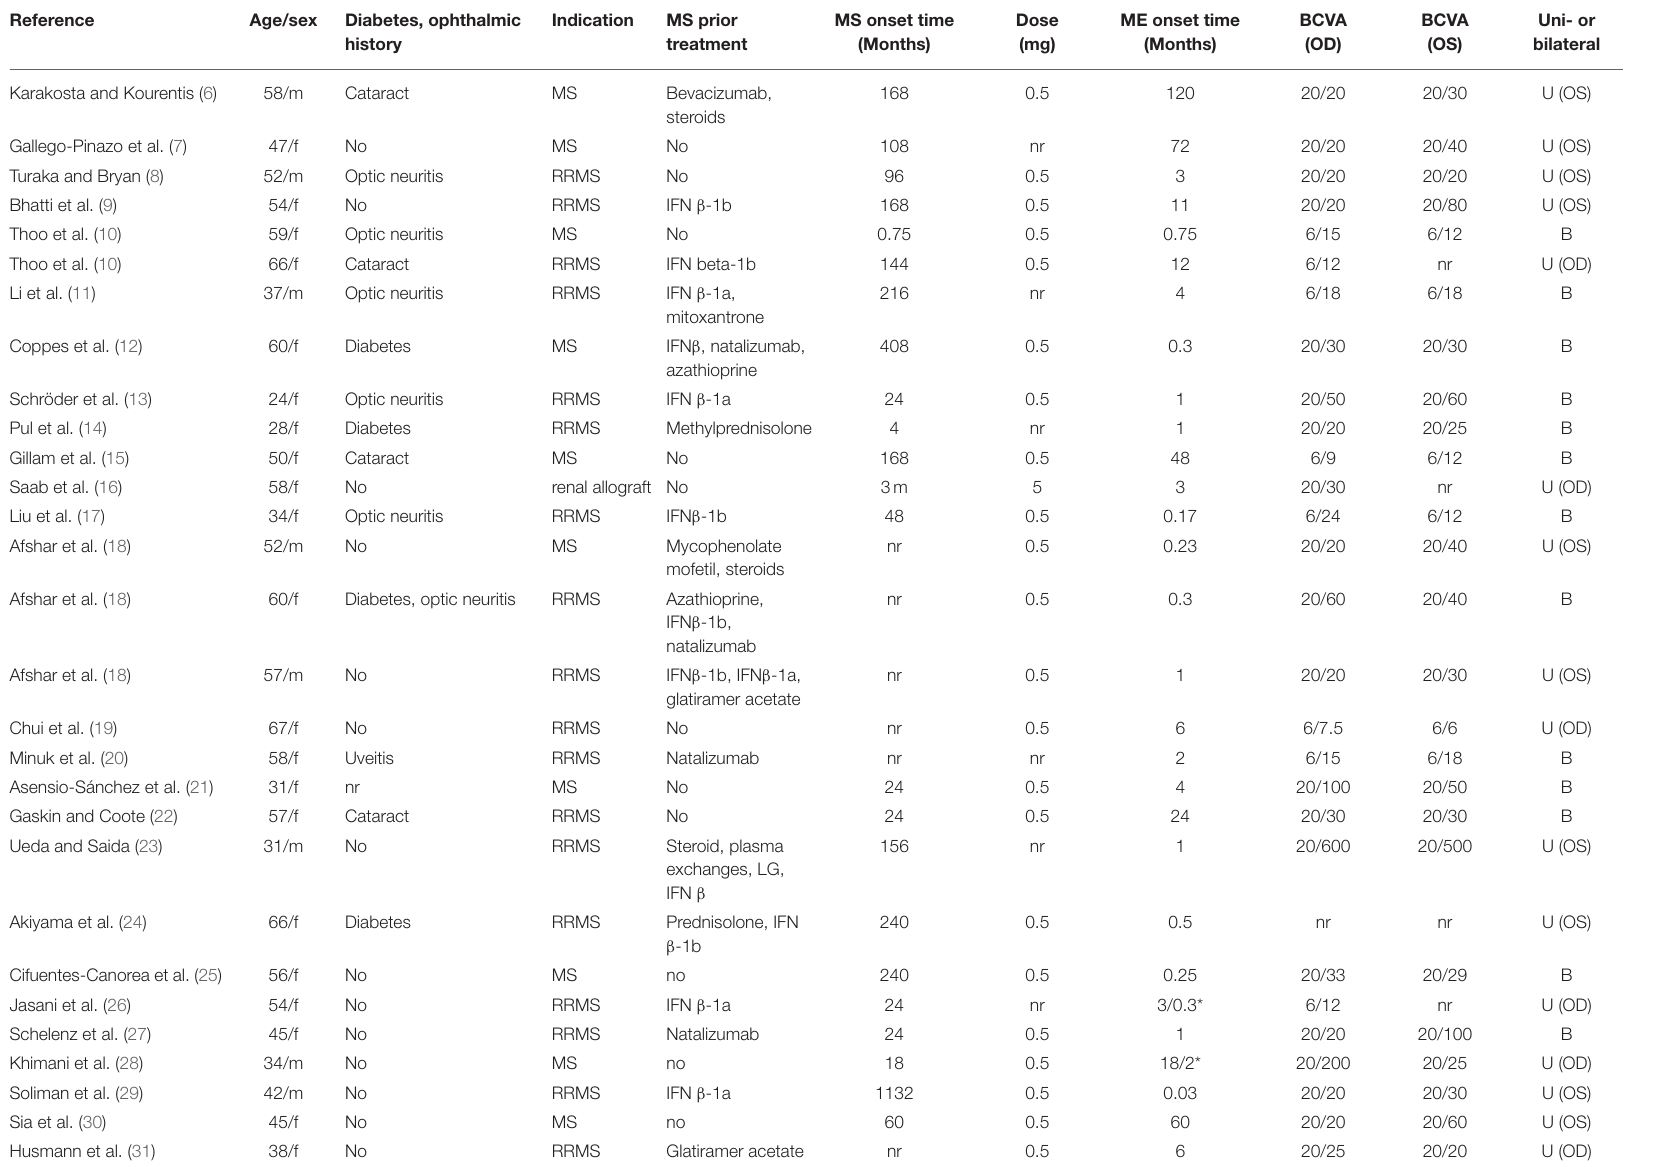
TABLE 1 | Basic information of the included 41